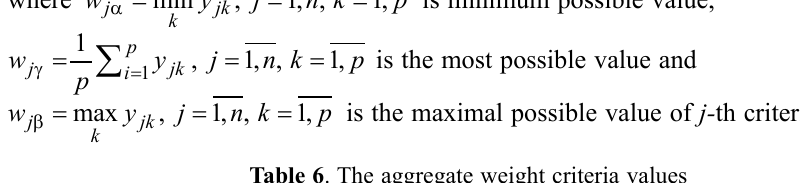
Table 6 . The aggregate weight criteria